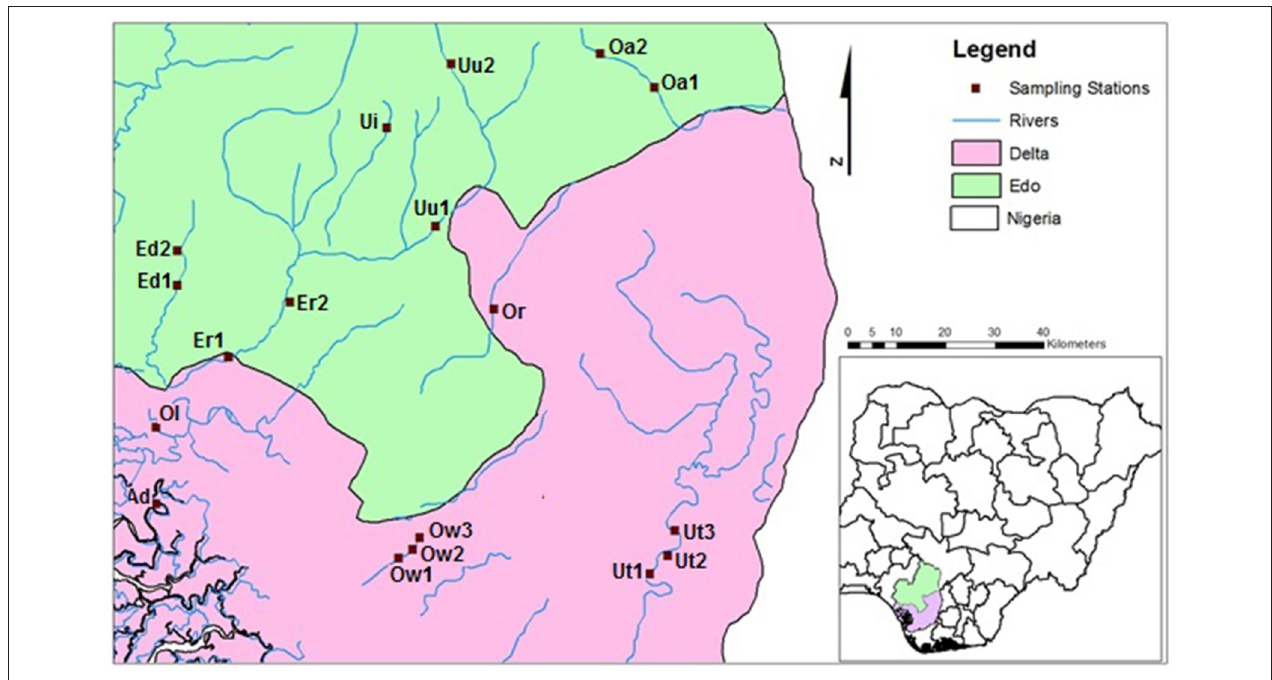
FIGURE 1 | Map of the study area showing the sampled stations.